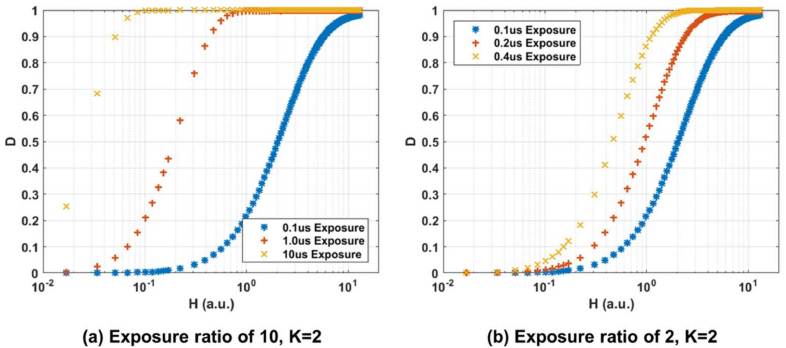
Figure 10. Measured normalized intensity (D or ‘Bit plane density’) to normalized input signal (H) for two sets of integration times for 2 photon threshold (K = 2). ( a ) Exposure ratio of 10 with Short = 100 ns, Mid = 1 µ s, Long = 10 µ s. ( b ) Exposure ratio of 2 with Short = 100 ns, Mid = 200 ns, Long = 400